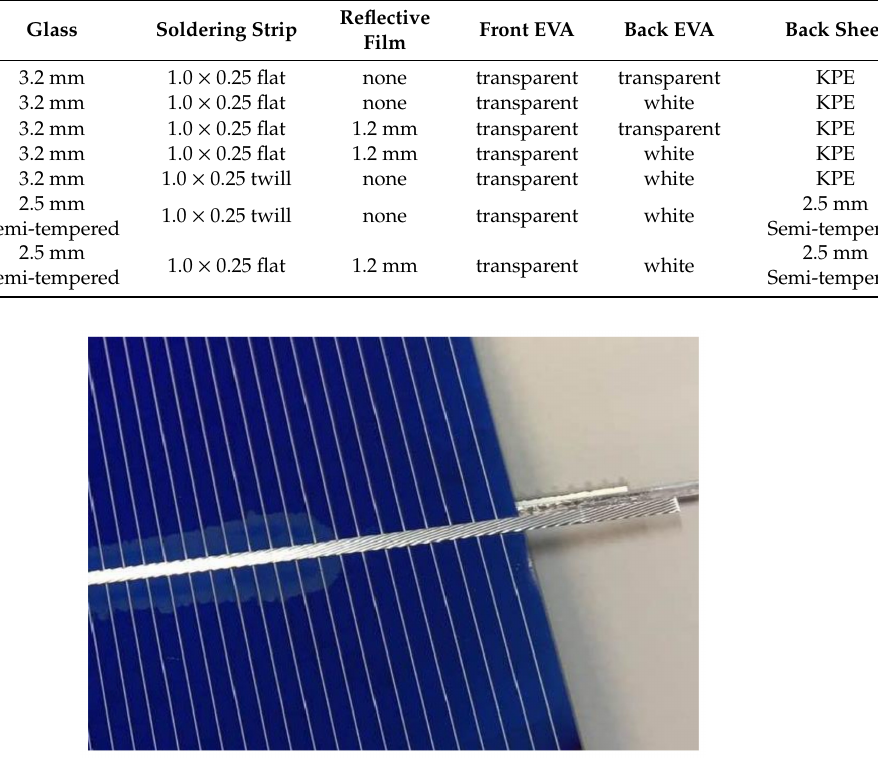
Table 6. The seven groups formed by di ff erent components.